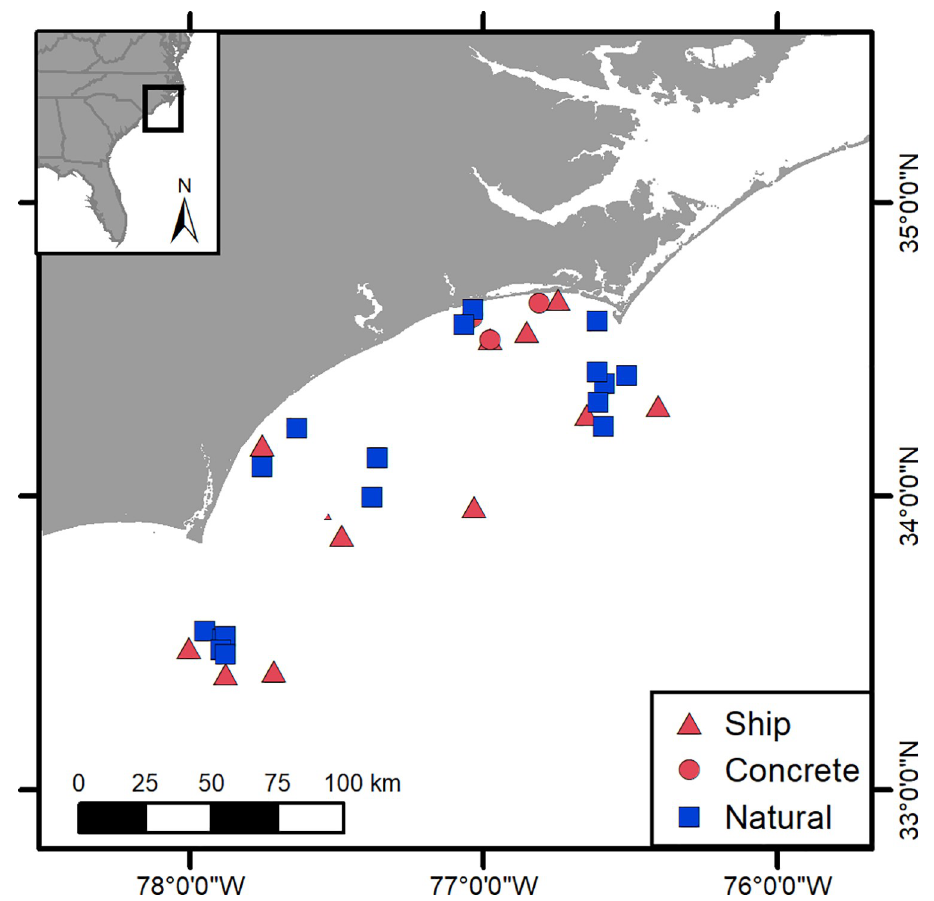
Fig 1. Location of study sites along the east coast of the US. Red represents fourteen artificial reefs. Red triangles are ships, and red circles are concrete artificial reefs. Blue squares represent sixteen natural rocky reefs.